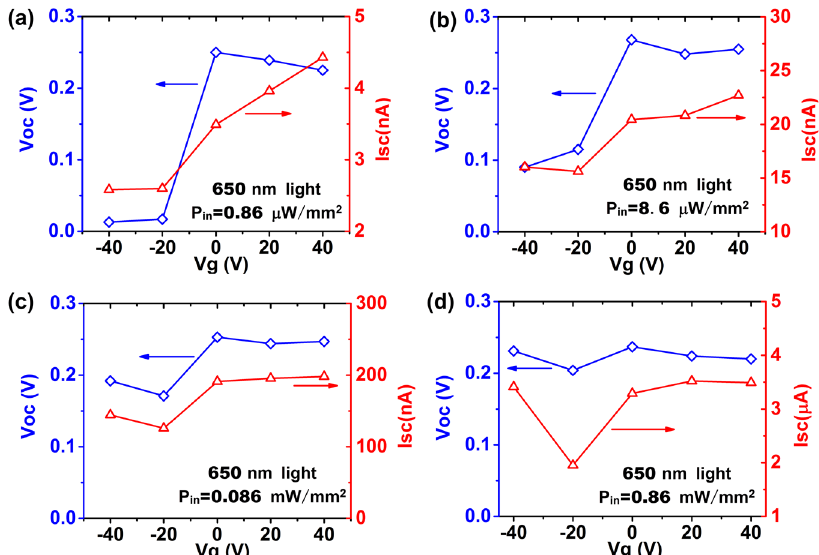
Fig. 4 Gate-tunable photoresponse. Dependence of the V oc and I sc on the gate voltage bias under 650 nm light illumination with a power density of a 0.86 μ W mm − 2 , b 8.6 μ W mm − 2 , c 0.086 mW mm − 2 , and d 0.86 mW mm − 2